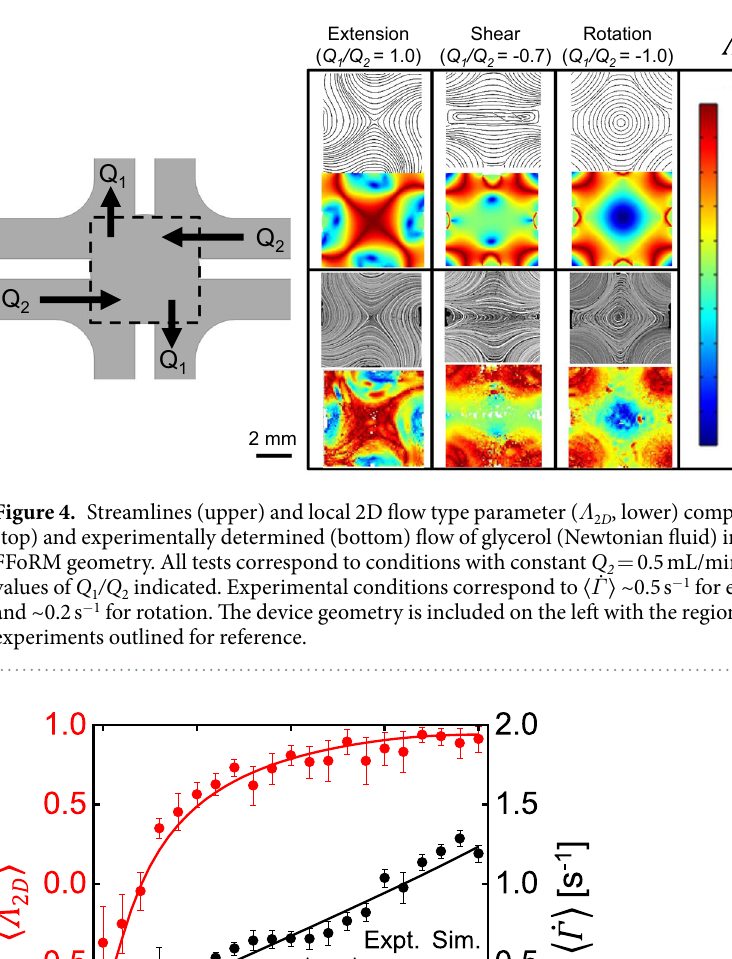
6 ScIENtIfIc RepoRts | (2018) 8:15559 | DOI:10.1038/s41598-018-33514-8